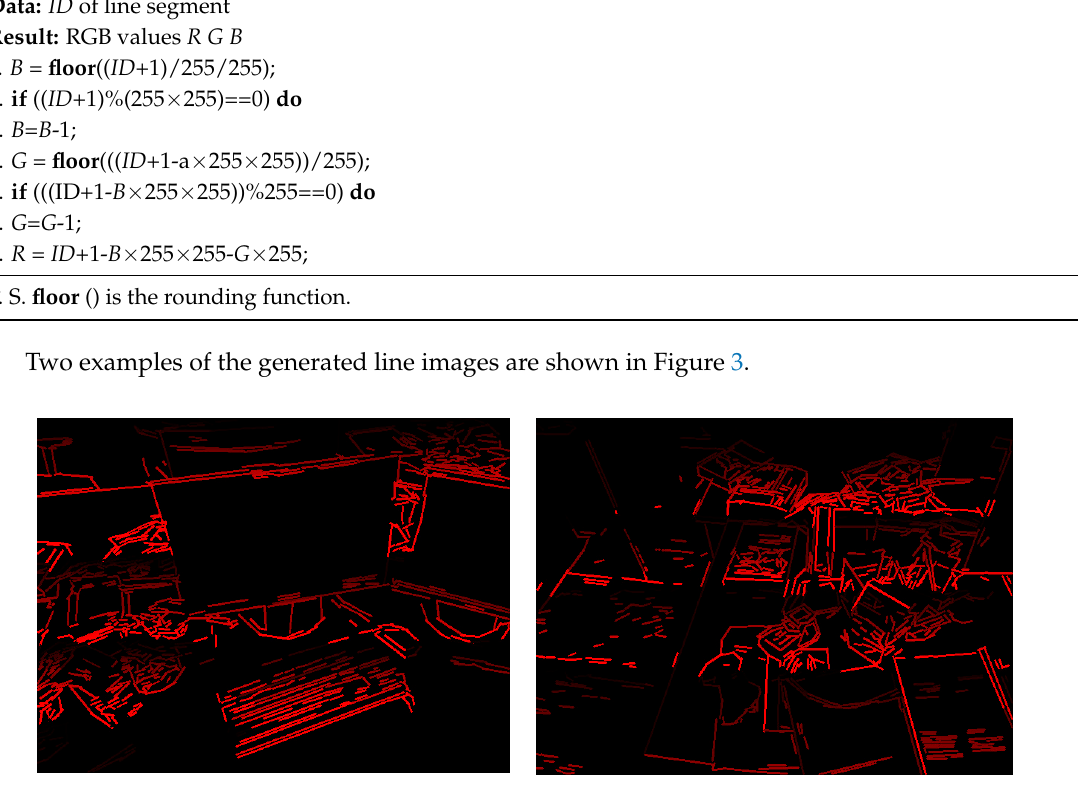
Figure 3. Two examples of the generated line images. The R values calculated by our algorithm is the largest and changes fastest, so the red is the most obvious color in the images.